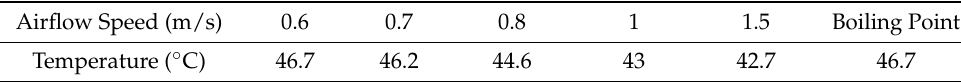
Table 3. Temperature at the outlet of the stator model for CCSSECAC under the rated working conditions.